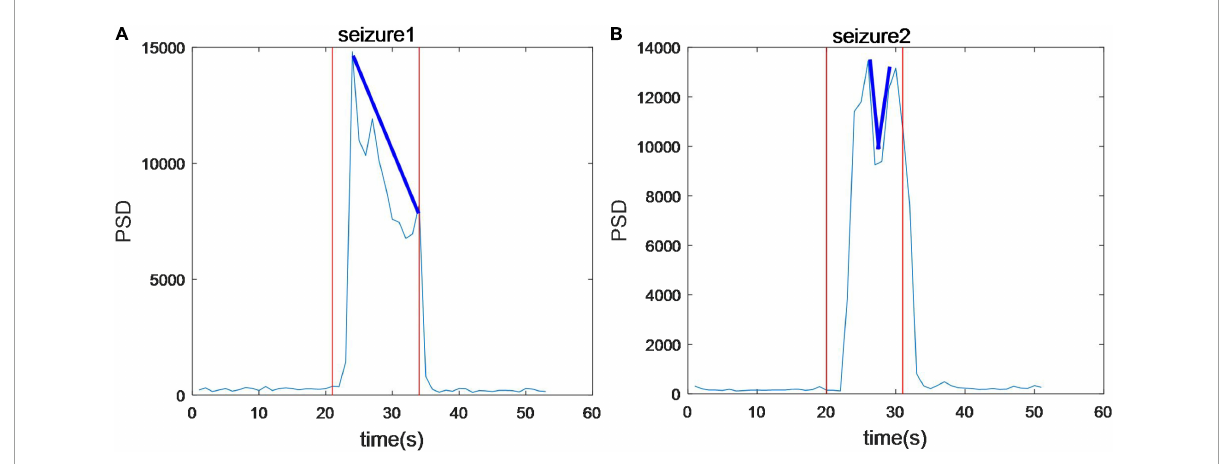
FIGURE3 The average power spectral density of 16 channels during seizures. The trend of PSD in two seizures in the same patient is different.